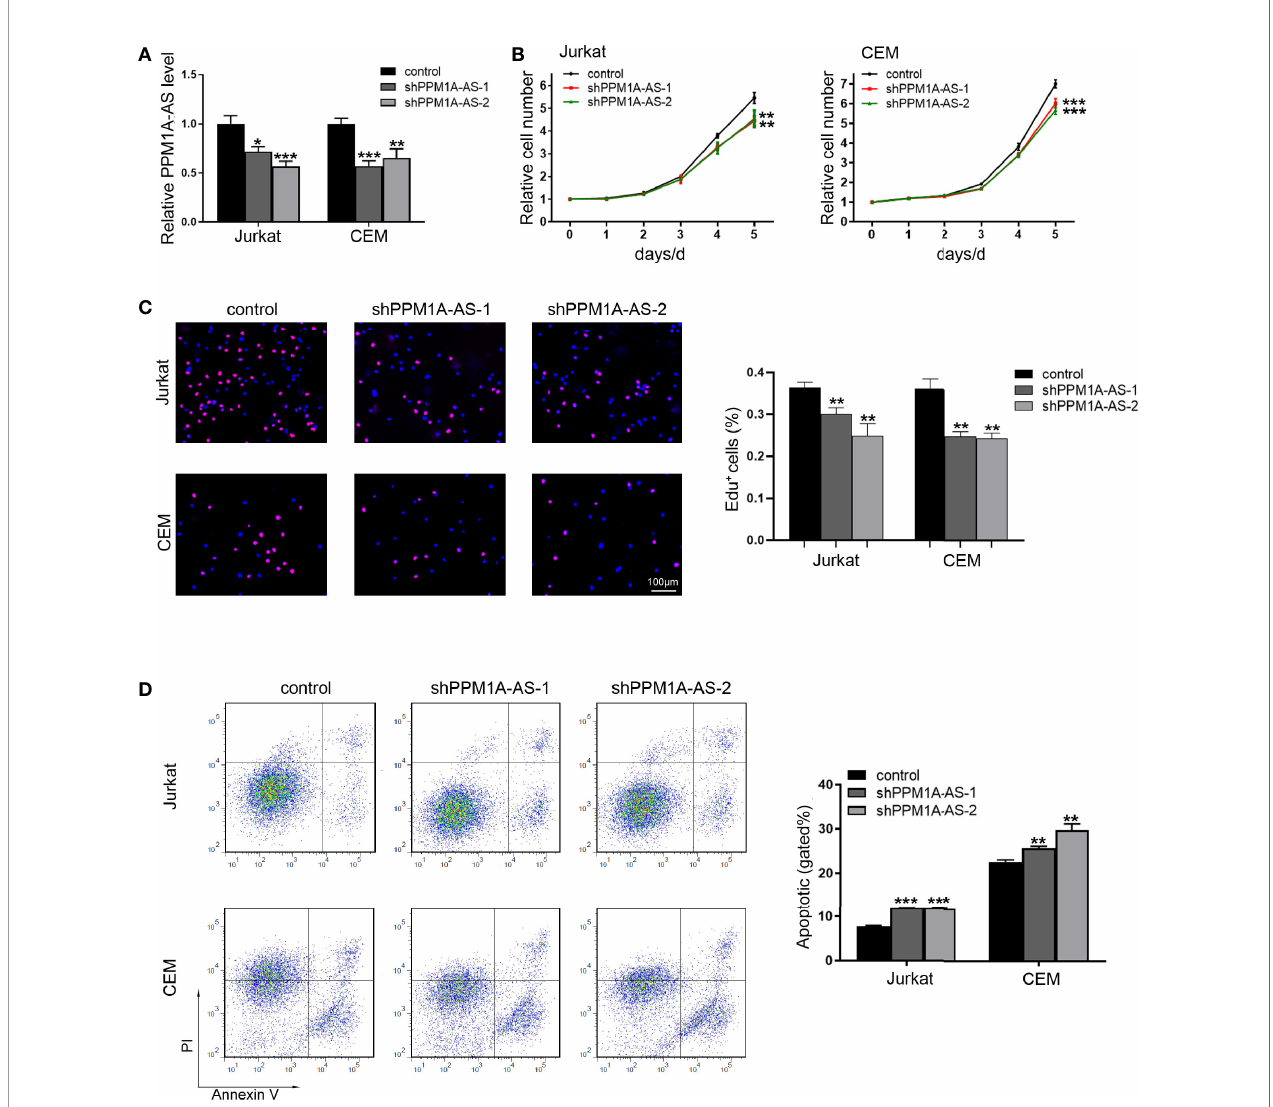
FIGURE 2 | Knockdown of lncRNA PPM1A-AS can inhibit cell proliferation and promote cell apoptosis. (A) The ef fi ciency of PPM1A-AS shRNAs in Jurkat and CEM cell lines. (B) CCK-8 analyses of the proliferation rates of Jurkat and CEM cells infected with control or PPM1A-AS-knockdown lentivirus. (C) EdU analyses of the proliferative ability of Jurkat and CEM cells infected with control or PPM1A-AS-knockdown lentivirus. Left panel: representative images; right panel: average percentage of EdU + cells counted in each fi eld. Scale bar, 100 m m. (D) Flow cytometry analyses of T-ALL cell apoptosis after infected with control or PPM1A-AS- knockdown lentivirus. Left panel: representative images; right panel: percentage of apoptotic cells. Mean ± SD. *P < 0.05. **P < 0.01. ***P <